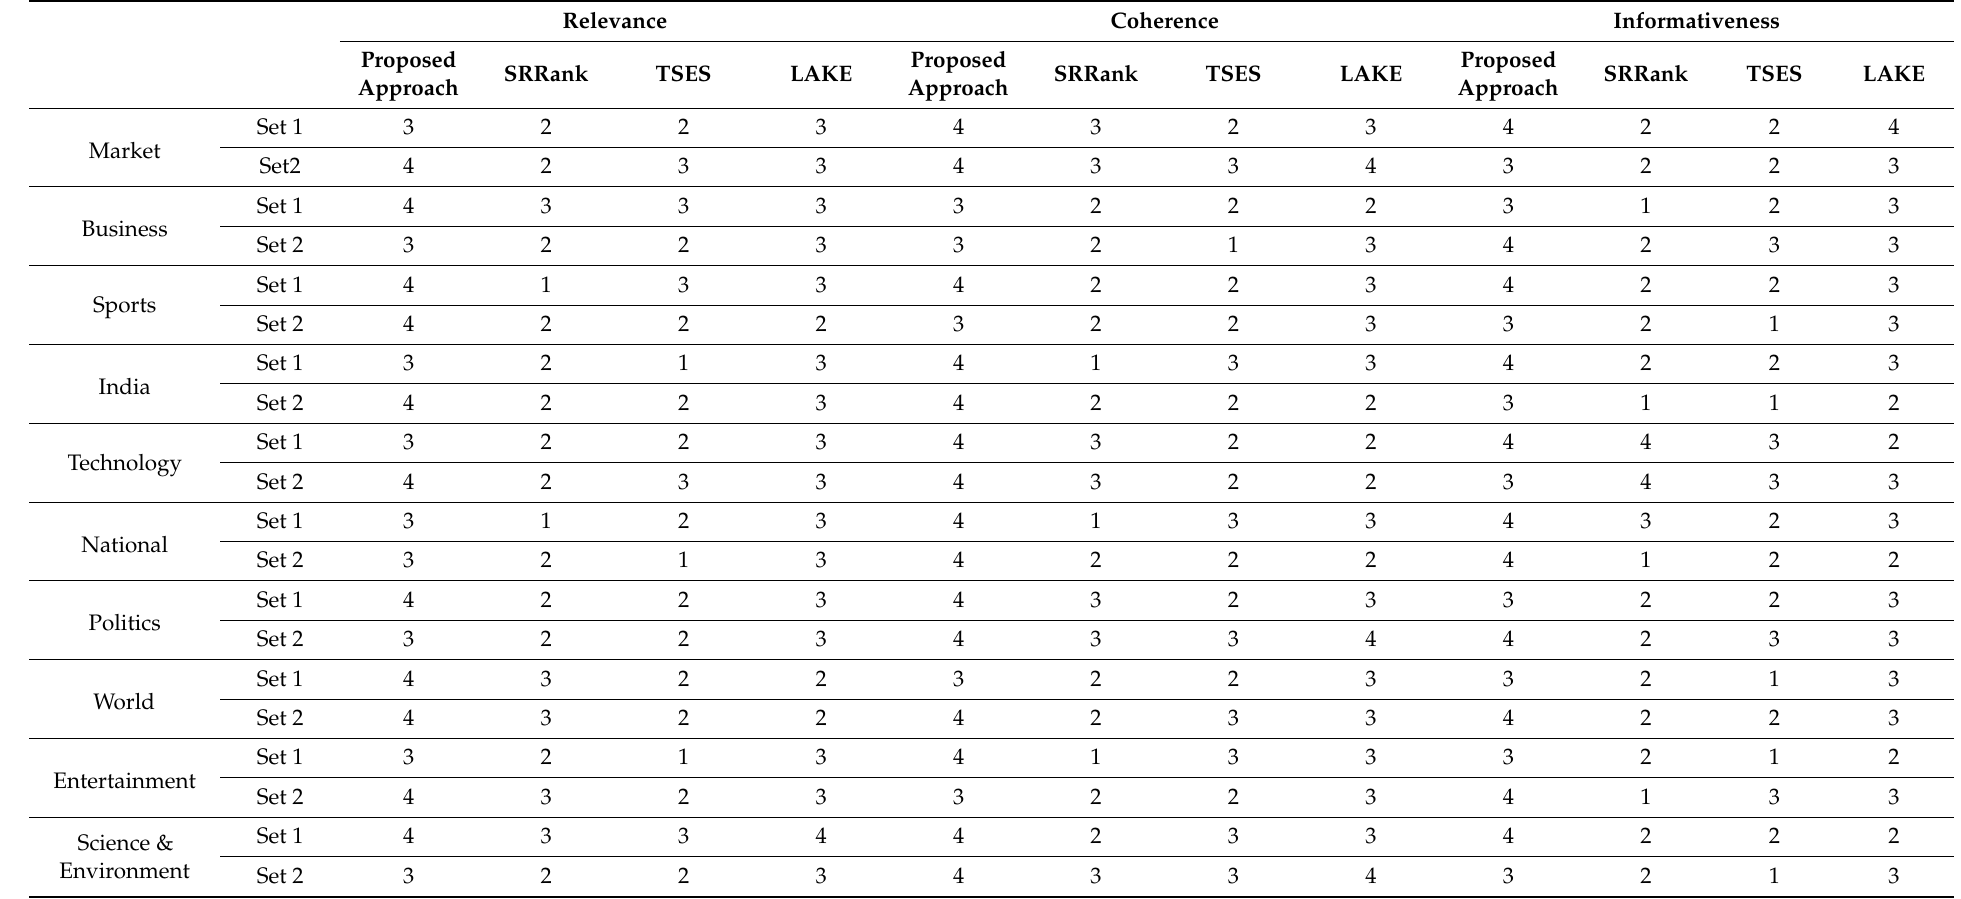
Table 9. Result evaluation based on